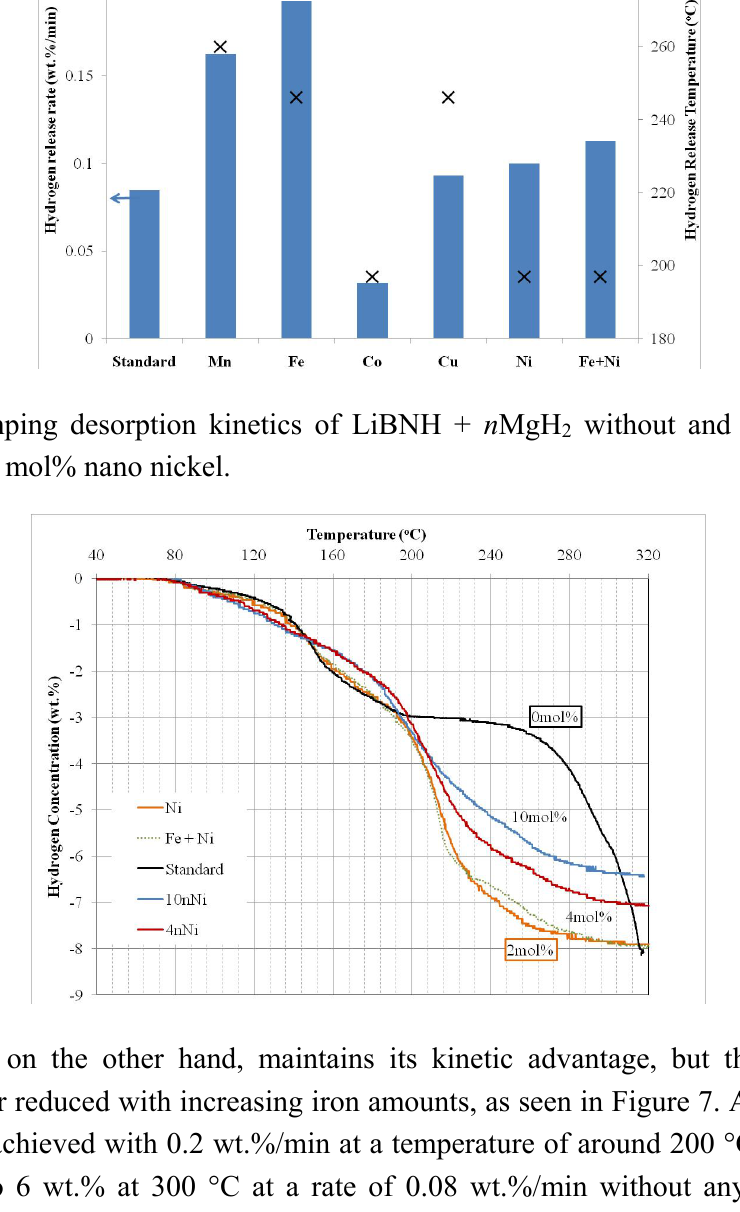
Figure 5. Comparison of hydrogen release temperature and hydrogen release rate of the standard LiBNH + n MgH without and with 2 mol% of various nano additives. 2